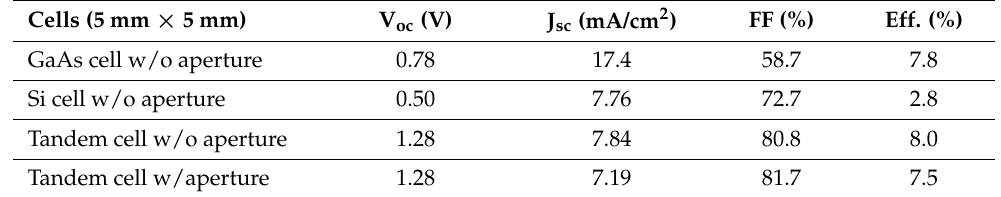
Figure 7. ( a ) LIV measurements of tandem cells with aperture mask. ( b ) LIV curves of GaAs top cell (black), Si bottom cell (red) and GaAs/Si tandem cell (blue). The solid and dash lines represent measurements with and without the aperture, respectively. ( c ) Quantum efficiencies of the GaAs top cell in the tandem device. Table 1. Summary of GaAs/Si tandem cell performance.